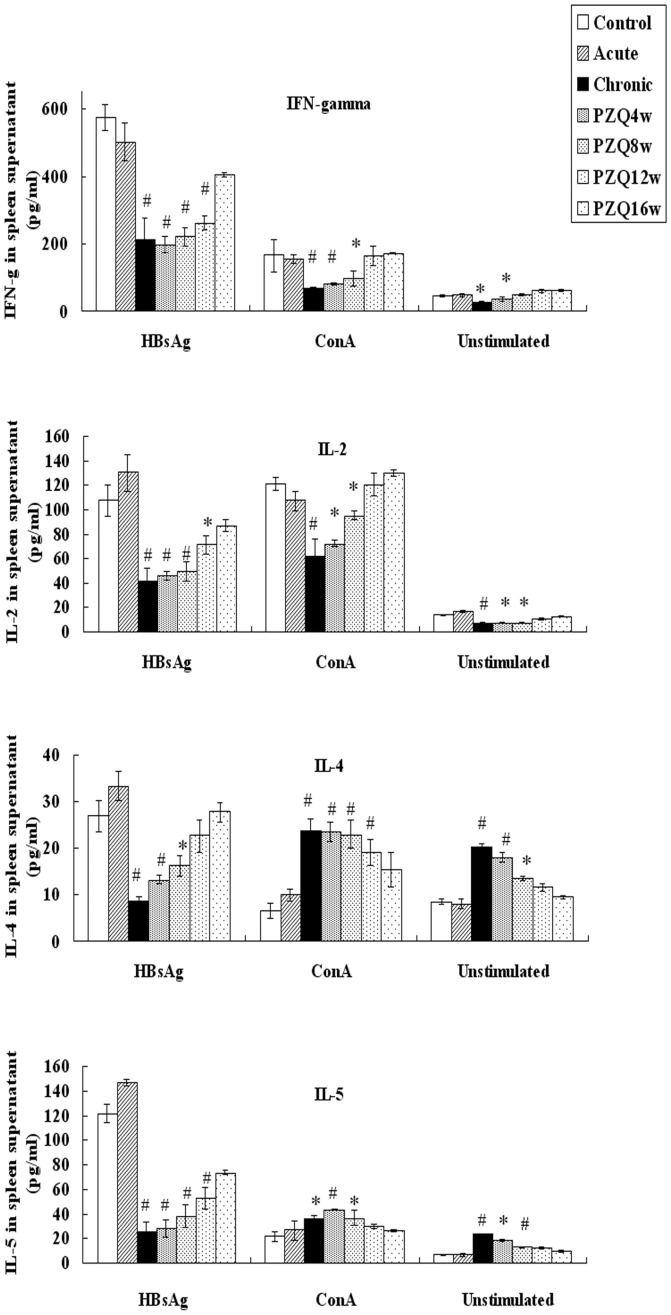
Concentrations of Th1and Th2 cytokines in spleen cell culture supernatants of mice.Spleen cells derived from the different groups at different times were tested under the same conditions. The experiment was performed twice (n = 10 mice/group) and each value shown represents the mean and SE of 20 value. P<0.05 versus control group. # P<0.01 versus control group.